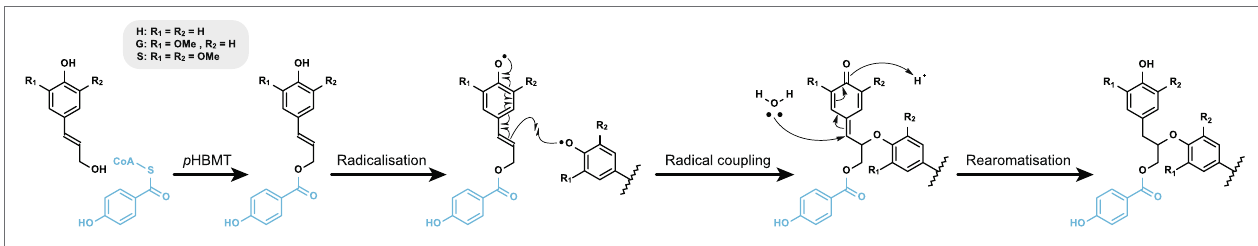
FIGURE 1 | Reaction scheme showing the incorporation of p -hydroxybenzoate moieties (blue) into lignin via the formation of monolignol conjugates by p -hydroxybenzoyl-CoA:monolignol acyltransferase ( p HBMT) and the participation of these conjugates in radical